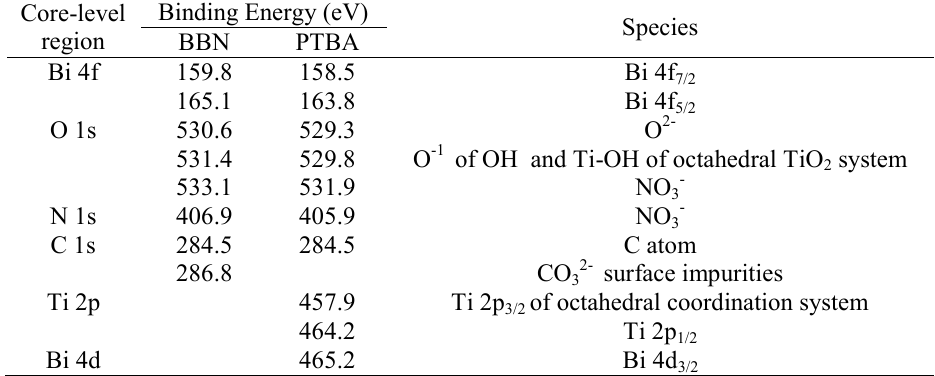
Table 2. XPS parameters for fitted peaks of BBN and PTBA sorbents.